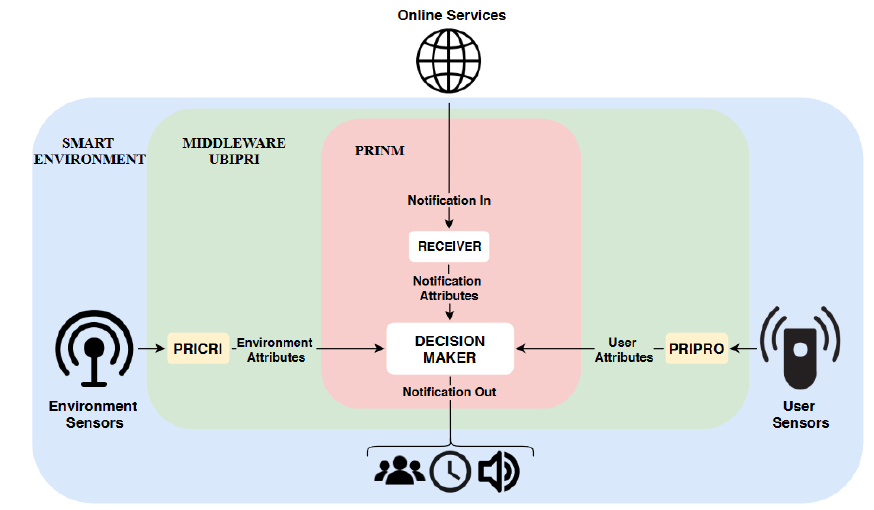
Figure 6. Notification management